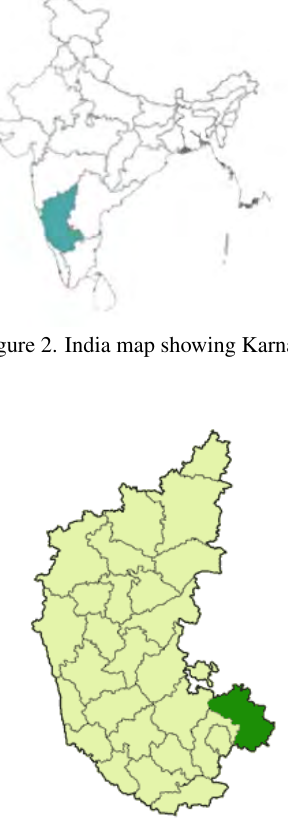
Figure 3. Karnataka map showing kolar